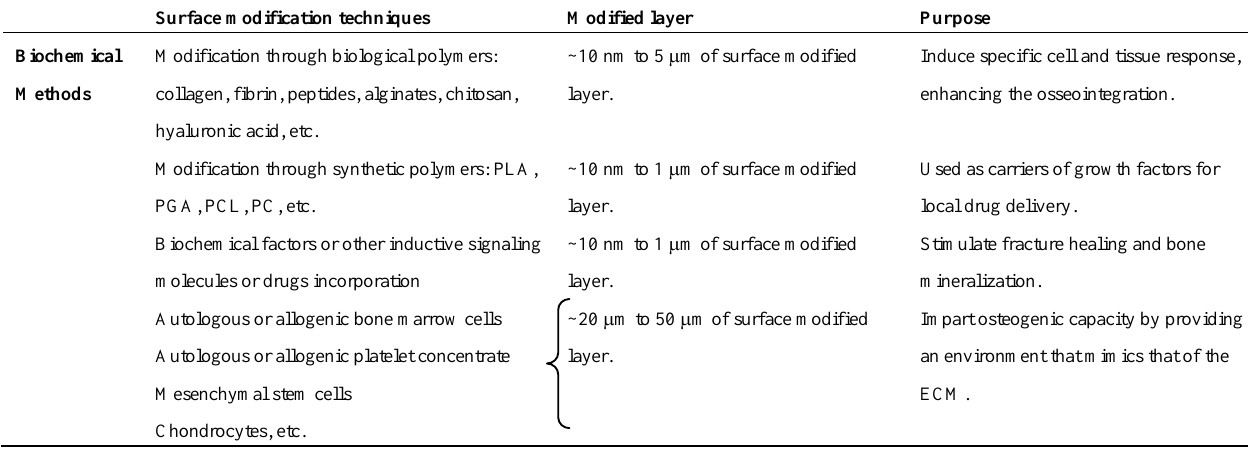
Table 3. Biochemical surface modification methods available for bone